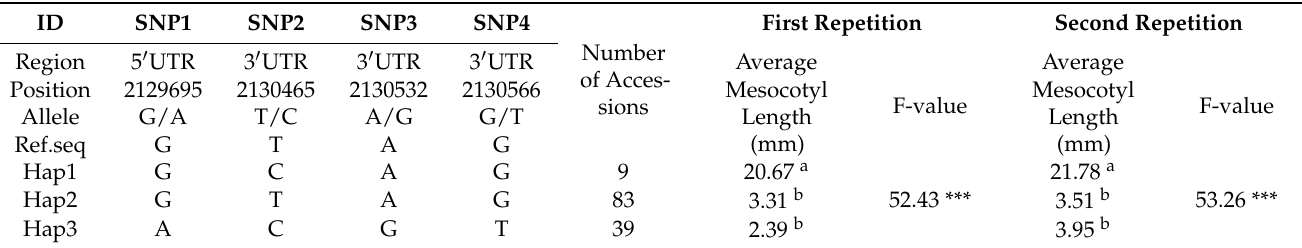
Figure 7. Haplotype analysis of Os08g0137800 . ( a ) Schematic representation of gene structure and SNPs positions in Os08g0137800 . Yellow, blue blocks and gray line represent exon, untranslated region (UTR) and intron regions, blue vertical bars represent SNPs. ( b ) Linkage disequilibrium (LD) analysis of SNPs in Os08g0137800 . D’ was used to indicate LD level, with LD blocks defined using the Confidence Intervals function in the analysis software. Red blocks indicate complete LD between each SNP. ( c ) Haplotype variation analysis. Colors indicate rice subspecies as indicated in the legend. Circle size indicates the number of varieties in each Hap. Traverse lines represent the extent of variation between three haplotypes. Table 5. Results of haplotype analysis of Os08g0137800 .